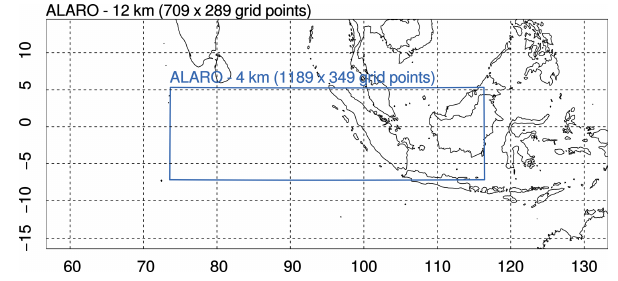
Figure 2. The ALARO 12km grid spacing domain (outer black box) and the ALARO 4km grid spacing domain (inner blue box).